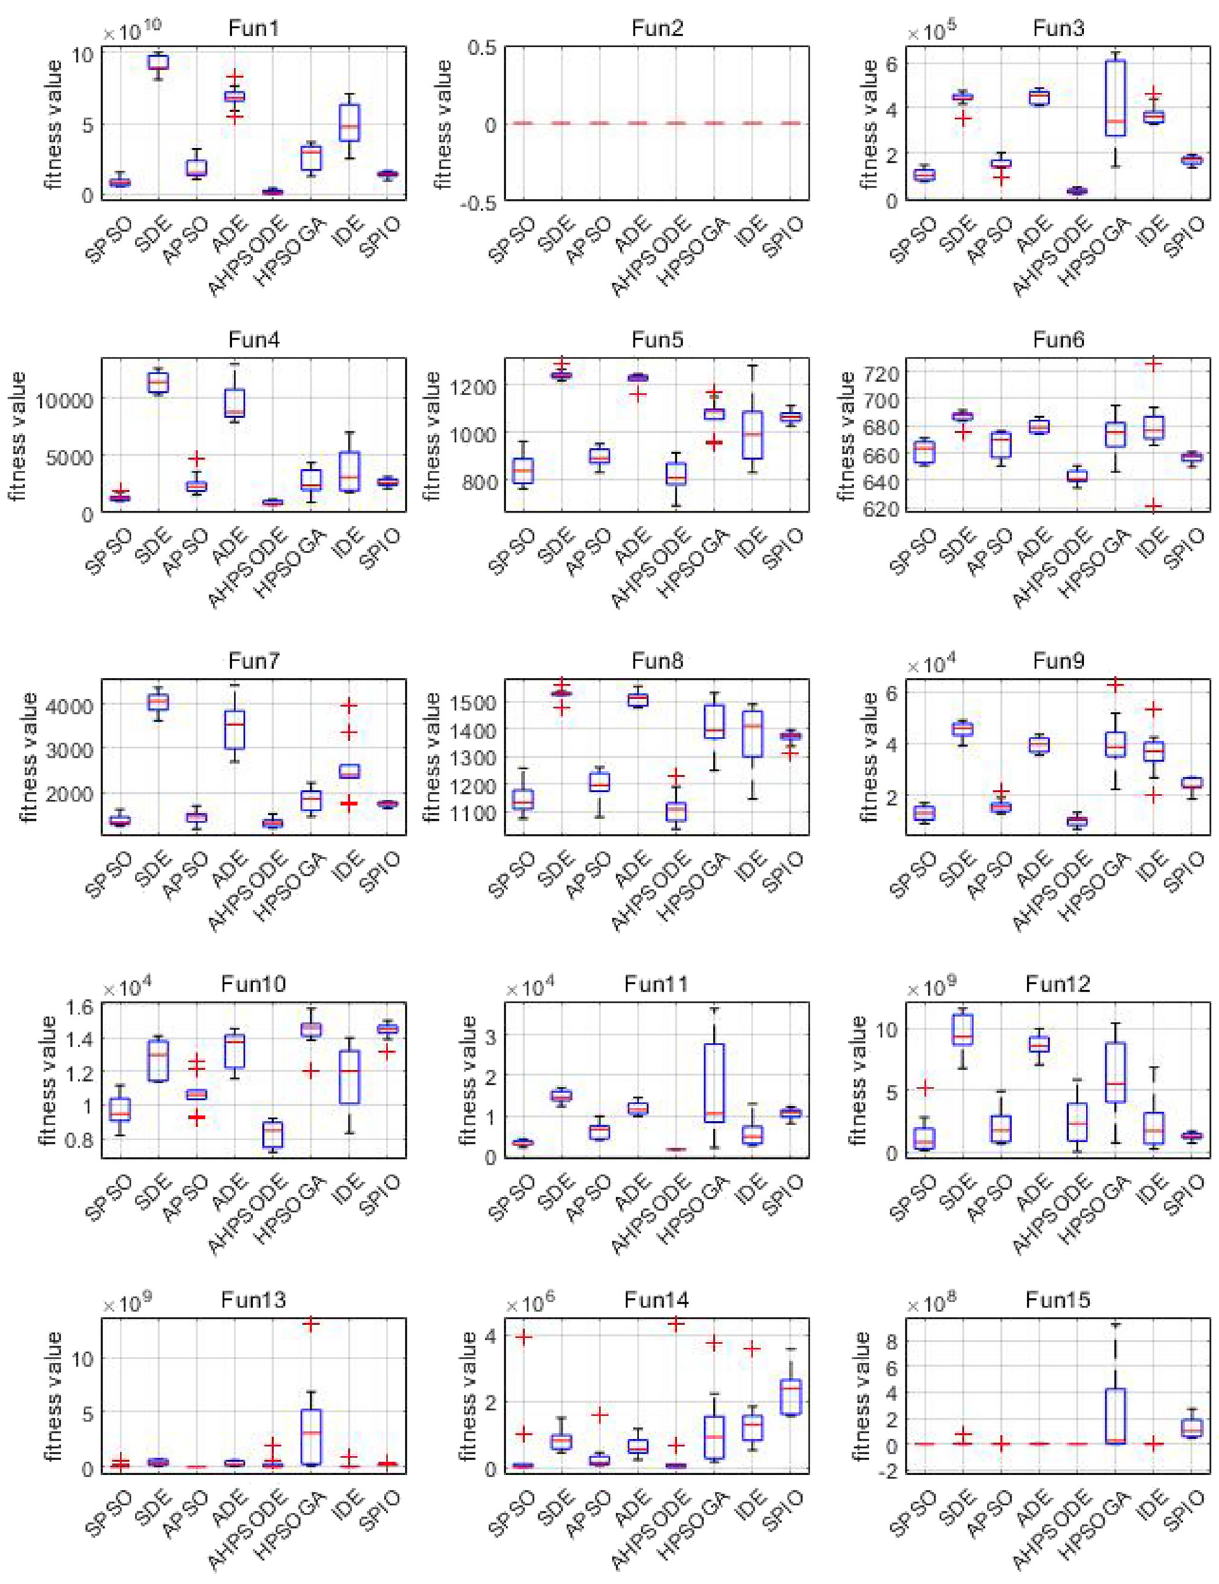
Fig. 21 Box plot of different algorithms on CEC 2017 at 50-D (Fun